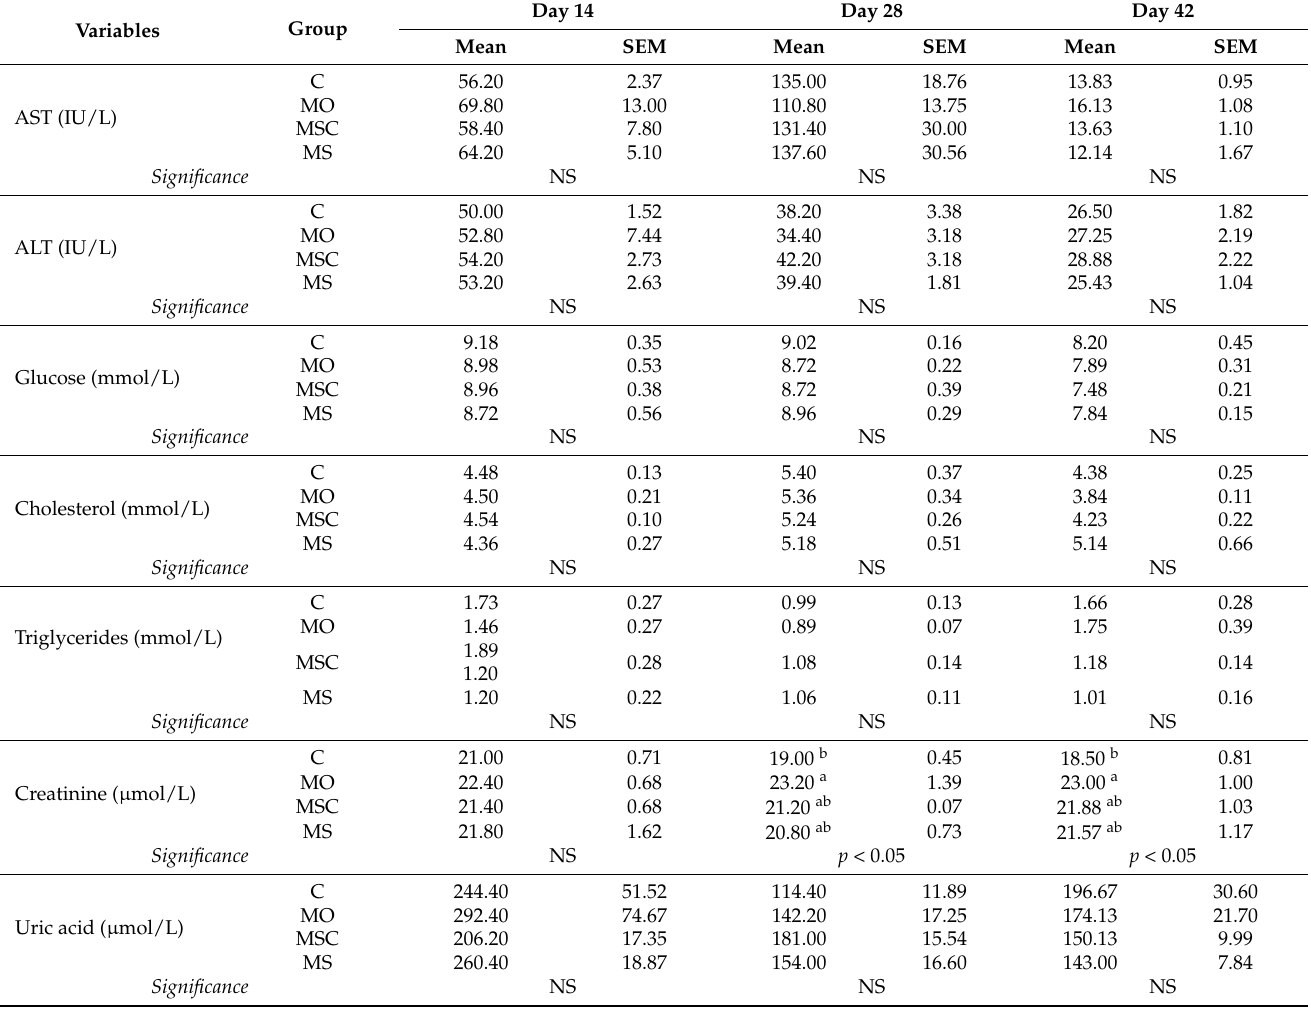
Table 3. Effect of dietary treatments on the blood serum concentrations of some chemical parameters.